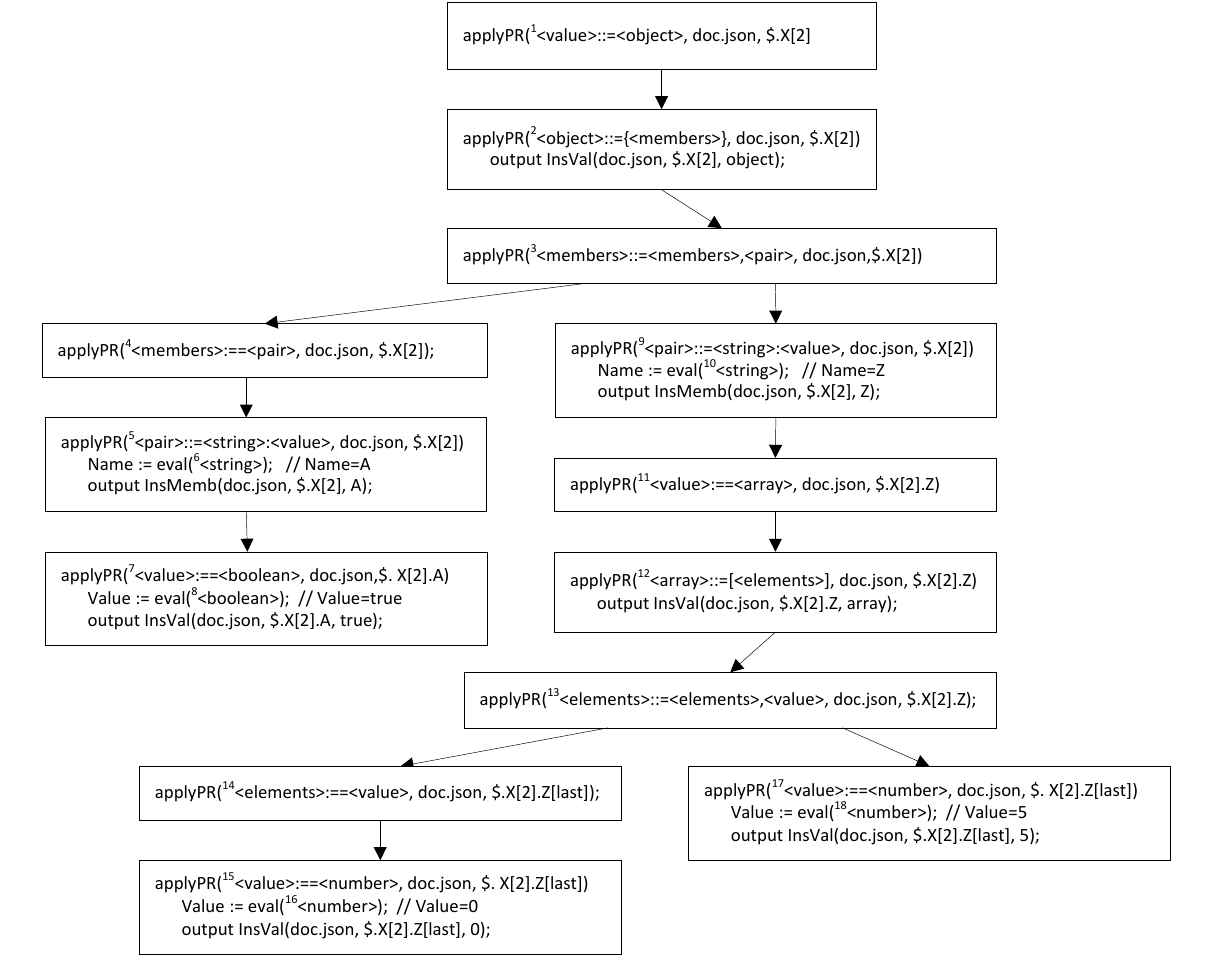
Figure A2. The execution trace of applyPR for the execution of the HLO Insert-